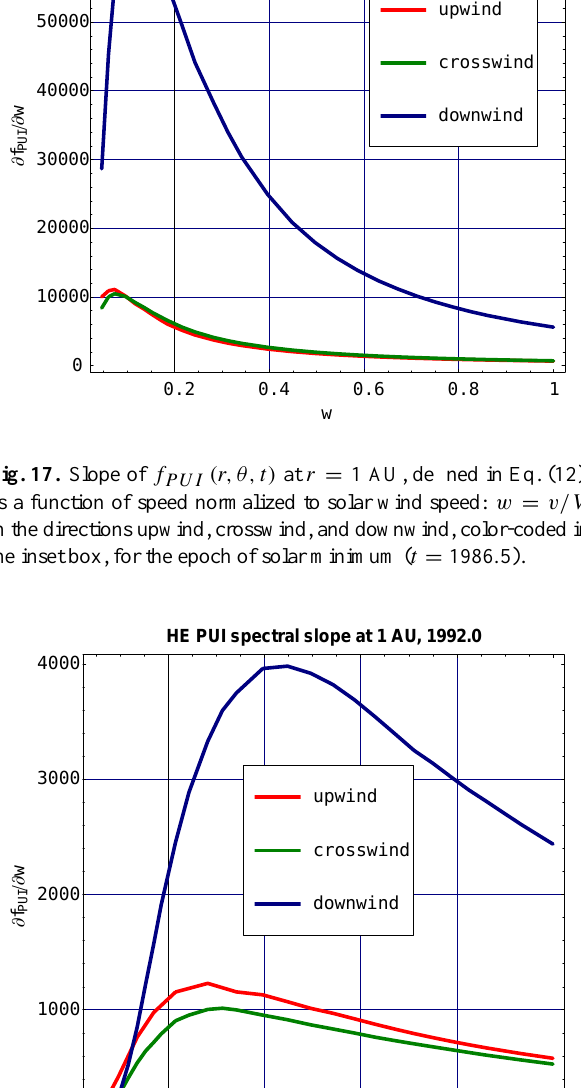
Fig. 16. The actual flux of He + pickup ions with respect to the flux averaged over time, for selected epochs during the solar cycle, presented as a function of heliocentric distance along the downwind axis in the log-log scale. The epochs are color-coded in the inset box.